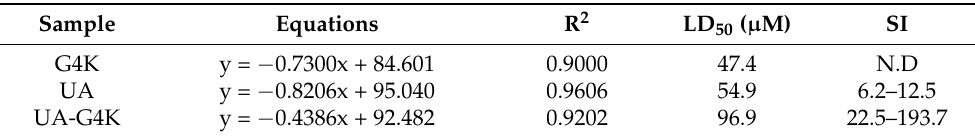
Figure 4. Linear regression models obtained from data relating to 24 h of cells exposure to G4K (purple line), UA (red line), and UA-G4K (light blue line). Table 4. Linear regressions equations, R 2 values, LD 50 of G4K, UA and UA-G4K, and SI ranges of UA and UA-G4K (24 h